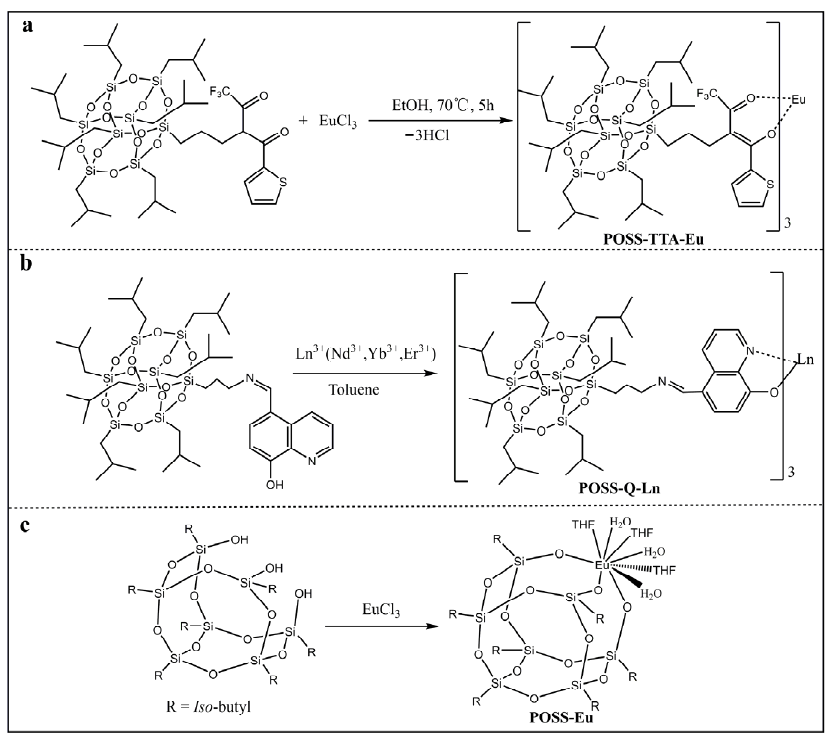
Figure 10. ( a ) Synthetic procedure of POSS-TTA-Eu [86]. ( b ) Synthetic procedure of POSS-Q-Ln [87]. ( c ) Synthetic procedure of POSS-Eu [88]. ( c ) Synthetic procedure of POSS-Eu